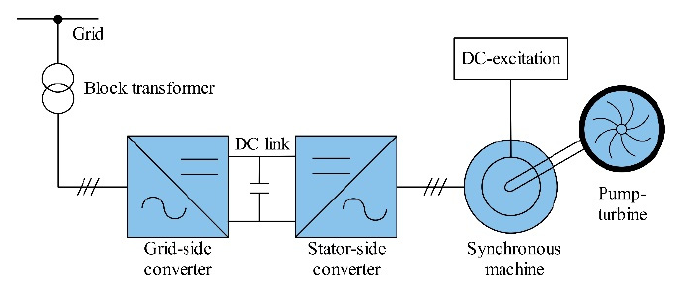
Figure 1. Unit based on the full-size converter.